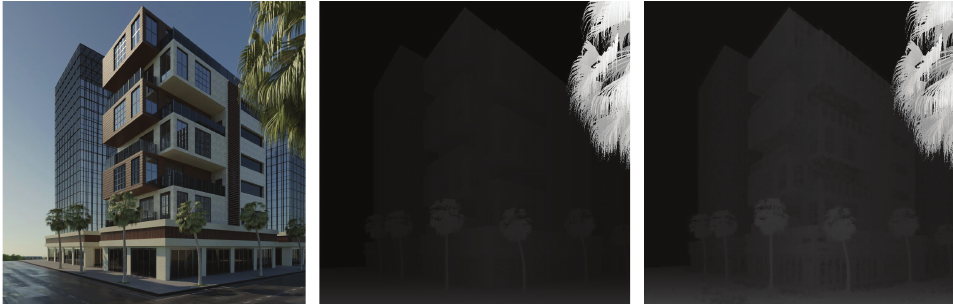
Figure 6. From left to right are rendered images, disparity ground truth, and estimated